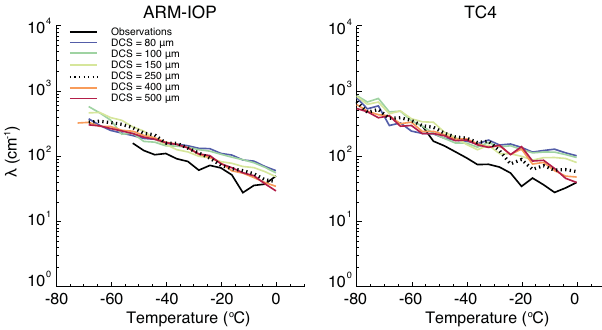
Figure 9. Same as Fig. 2, but with simulations using different D cs